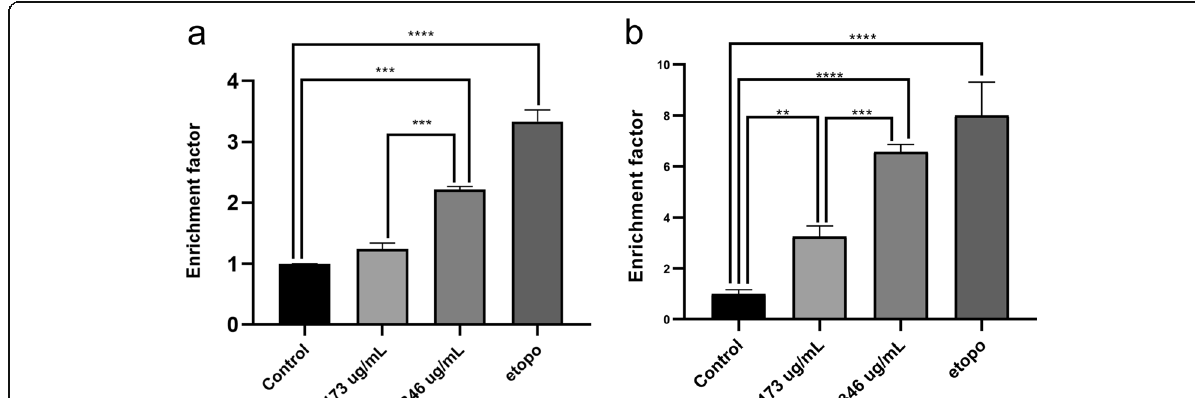
Fig. 3 The quantitative effect of AELE on induction of apoptosis using Cell Death ELISA. Cell Death ELISA on Monomac-1 ( a ) and KG-1 ( b ) cells, treated with the two concentrations of AELE closest to the IC50 (173 and 346 μ g/mL), as well as a positive control treated with etoposide for 24